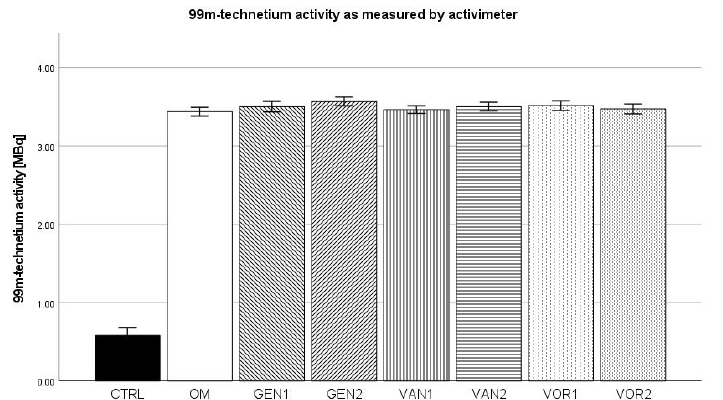
Figure 10. Mean 99m technetium uptake per group as measured by the activimeter. The error bars show the error of mean.